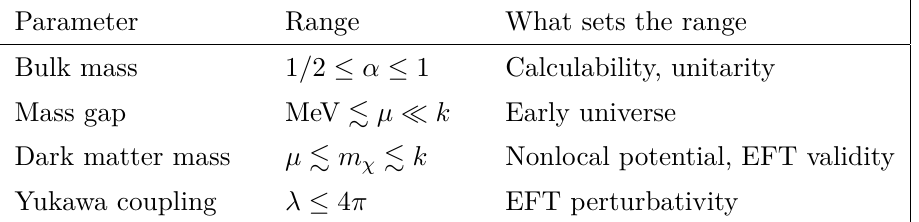
Table 1 . Range of parameters in our model. The AdS curvature is set to k = 10 TeV ; larger values generically suppress self-interaction effects. The dimensionless brane-localized masses and kinetic terms defined in (3.6) and (3.11) are assumed to be O (1) , with the exception of b UV which is tuned to zero to reproduce the long-range behavior, (2.2). The early universe bound on µ is described in section